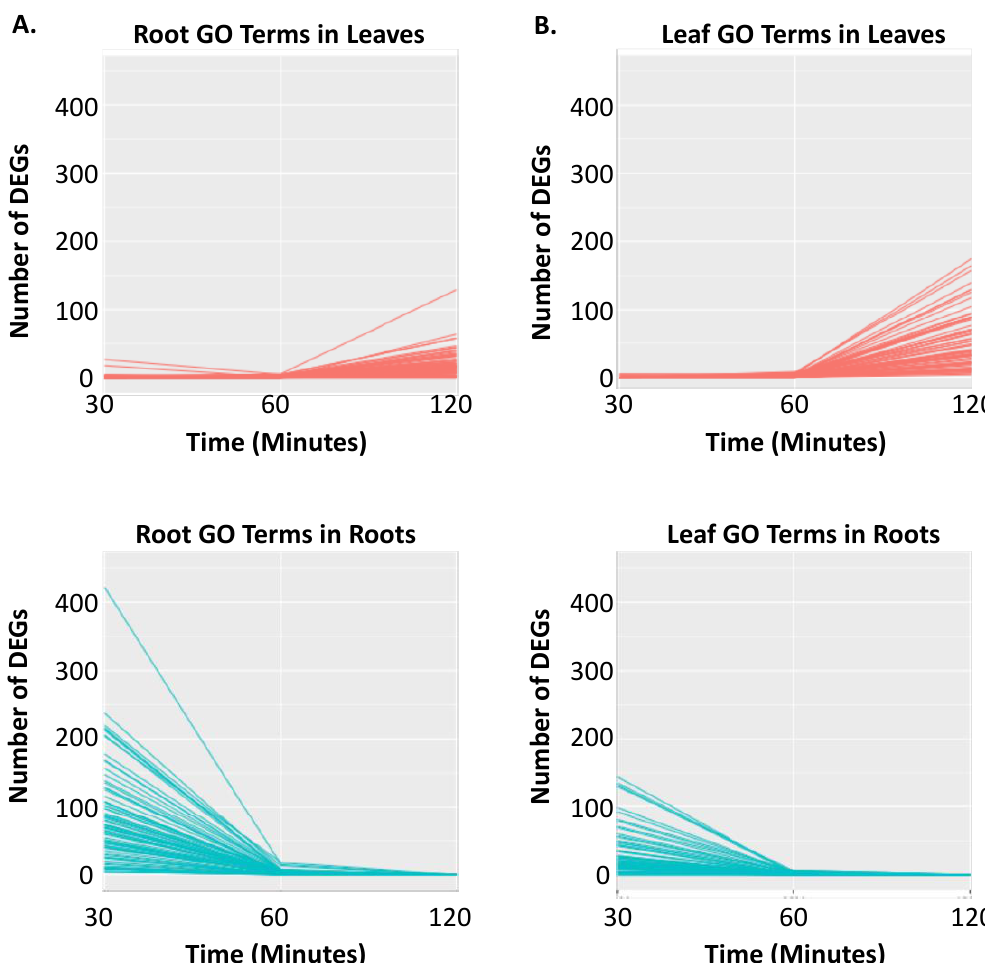
Figure 6. Evidence for root to shoot signaling in the soybean iron stress response. In the roots and leaves, we identified 74 and 72 unique overrepresented GO terms, respectively. To examine gene expression differences, we monitored the number of differentially expressed genes for each significant GO term across time in both roots (red) and leaves (blue). For each of the GO terms examined, differential gene expression is observed first in the roots, followed by expression later in the leaves. ( A ) Number of DEGs in significant root GO terms across tissues and time. ( B ) Number of DEGs in significant leaf GO terms across tissues and time.